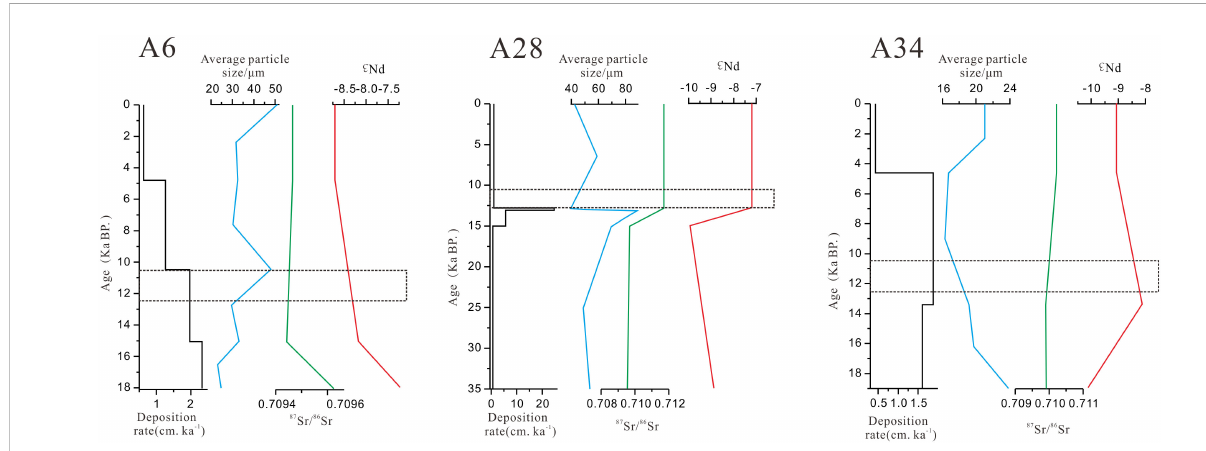
FIGURE 8 Chronological framework of sediments in A6, A28 and A34 cores (the middle of the dotted line is the Younger